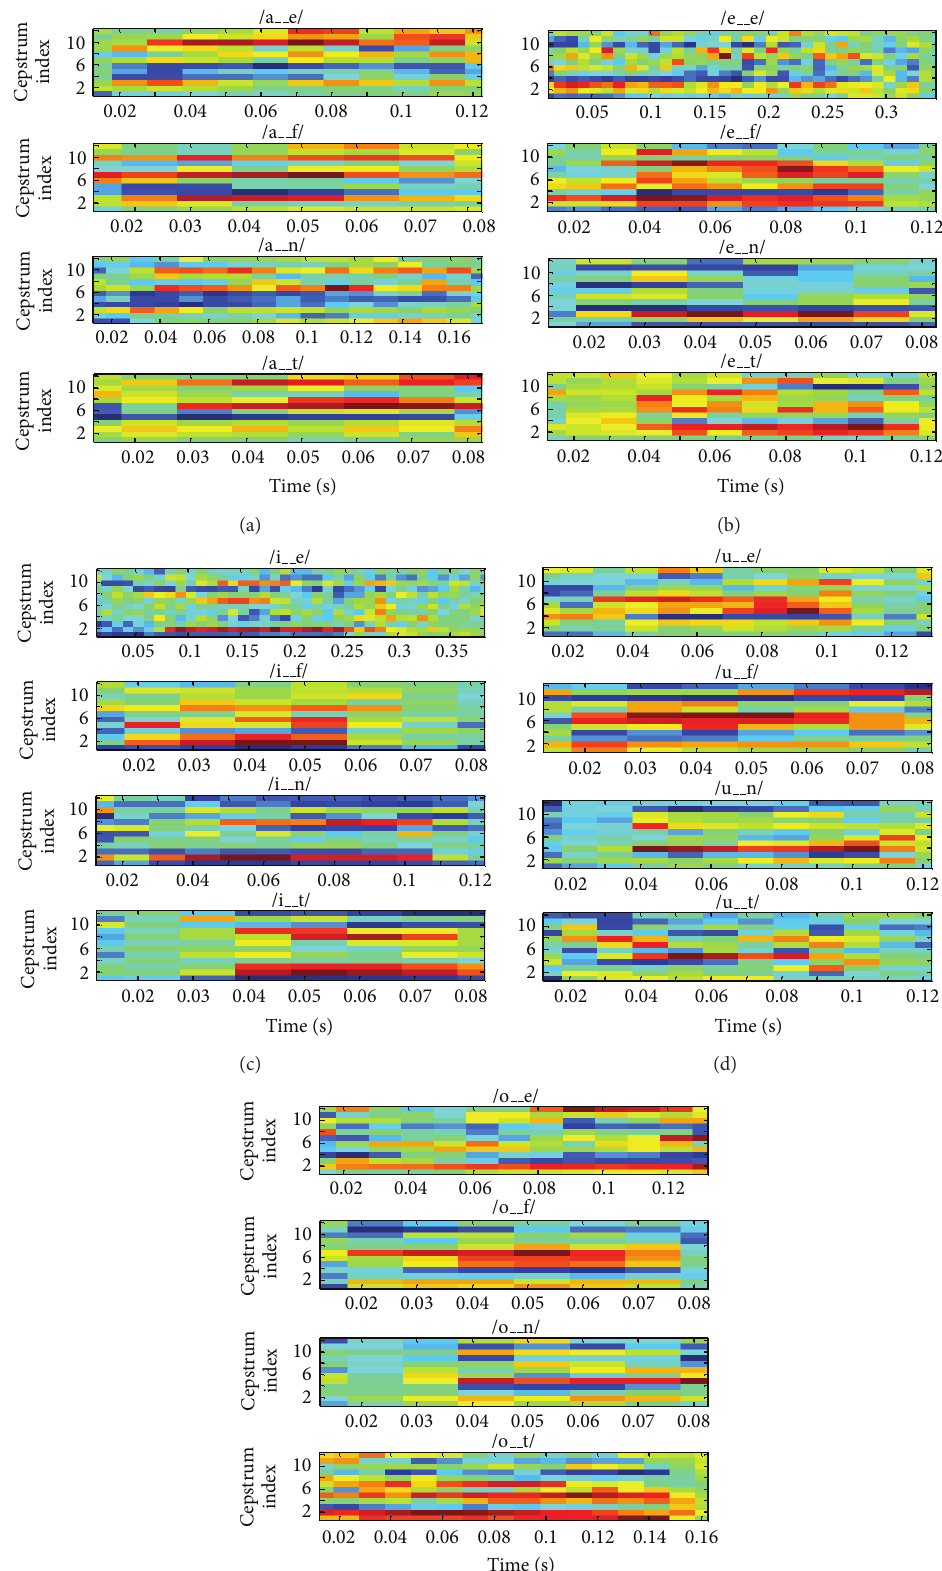
Figure 4: MFCCs obtained for some emotion-specific vowels of a male speaker from the built emotional speech database. Description of identifiers: e = anger, f = happiness, n = neutral, and t = sadness. HTK coding parameters: TARGETKIND = MFCC E D A, WINDOWSIZE = 250000.0, USEHAMMING = T, PREEMCOEF = 0.97, NUMCHANS = 26, CEPLIFTER = 22, and NUMCEPS =